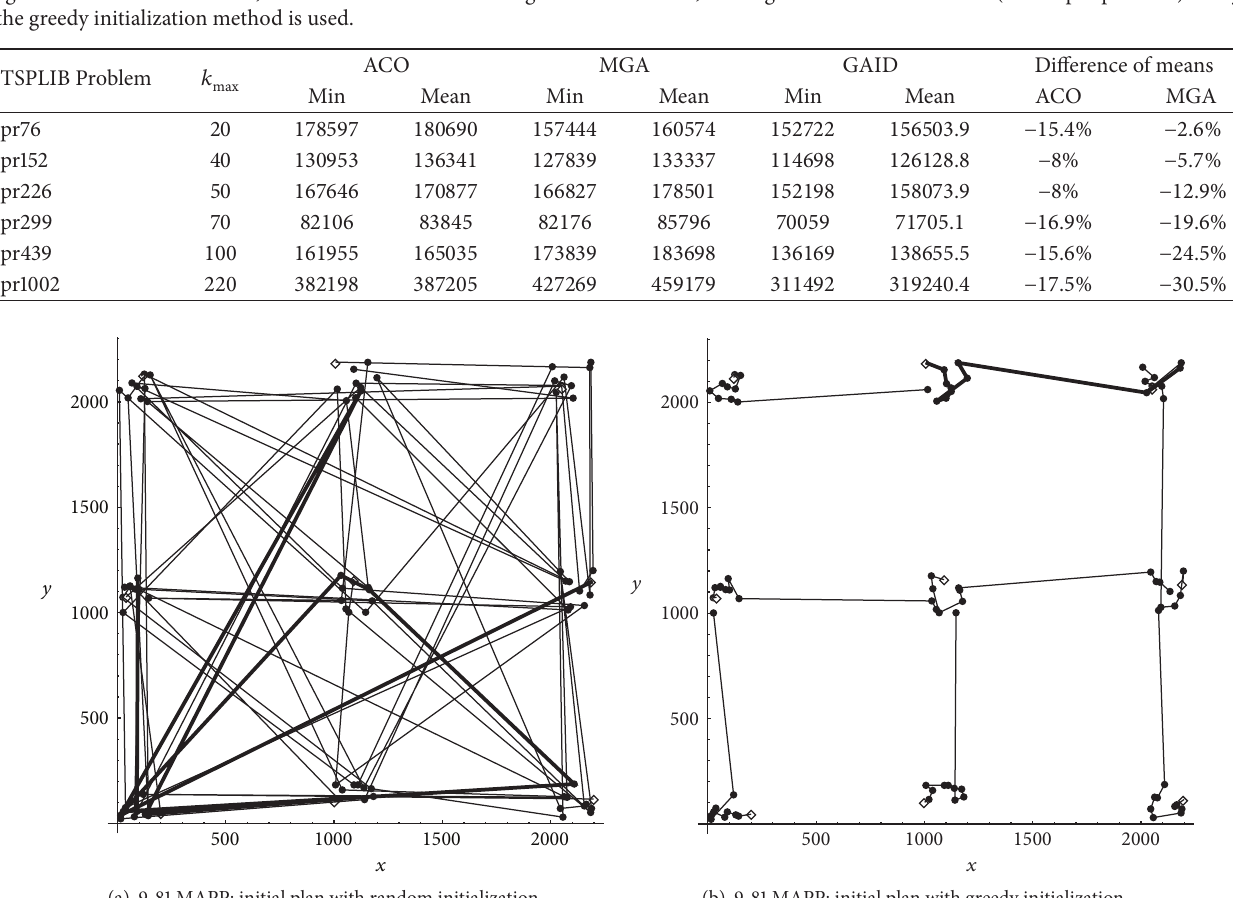
is the maximum number of targets an max